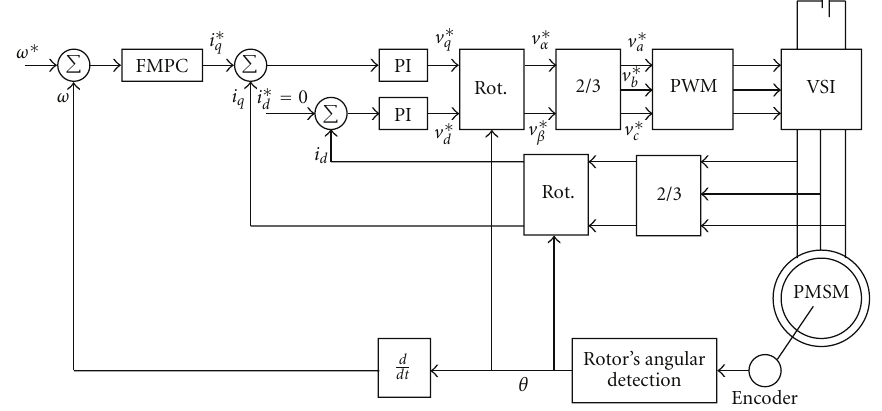
Figure 2: Block diagram of the proposed PMSM speed control